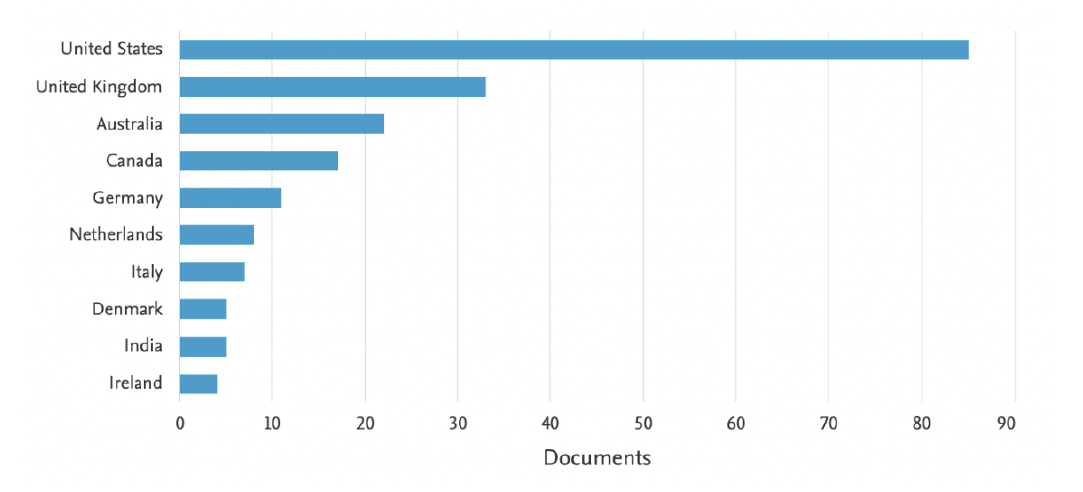
Figure S1: Scopus™ territory analysis (28 April 2021). Documents by country or territory. Compare the document counts for up to 15 coun-